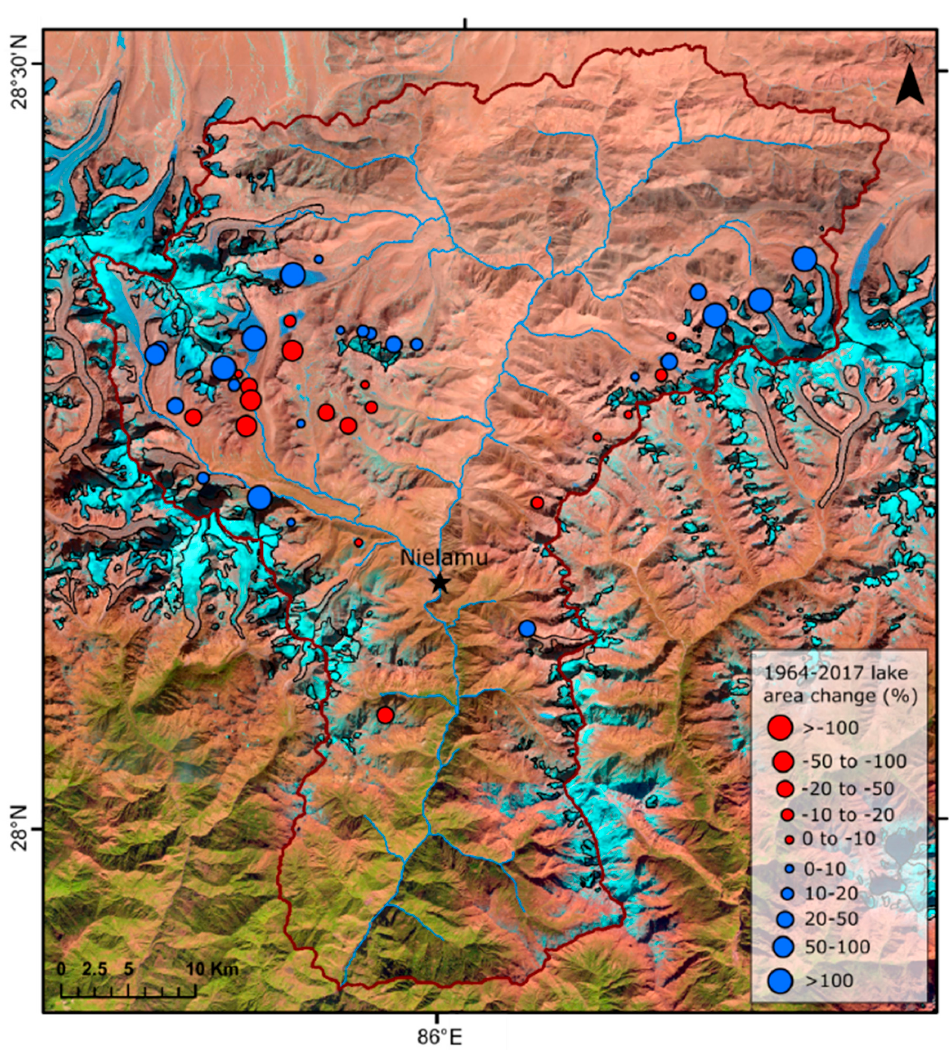
Figure 3. Area change of glacial lakes between 1964 and 2017 (data source: [42]).